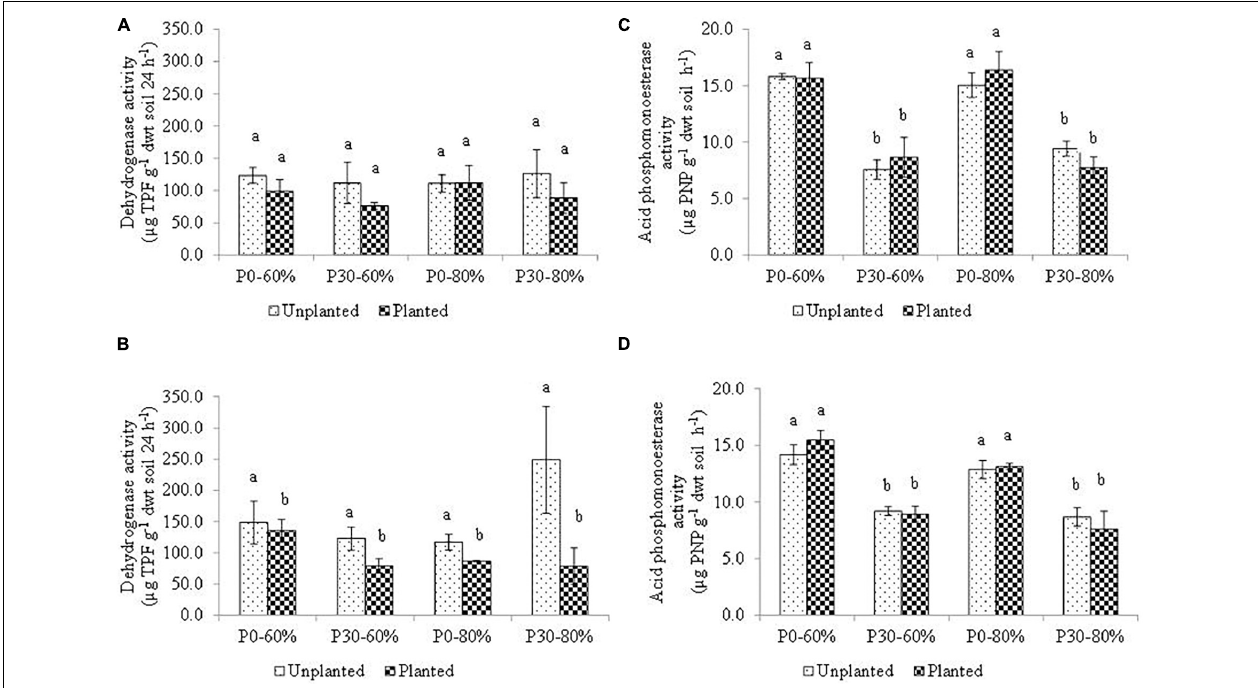
FIGURE 4 | Mean dehydrogenase activity measured in bulk soil within the (A) D1 and (B) D5 and mean acid phosphomonoesterase measured in bulk soil within the (C) D1 and (D) D5 sub-sections of sampled mesocosm. Activity was measured after four months incubation in a growth chamber. Soil used in the experiment originated from an established inorganic phosphorus (P) fertilization field trial (44 years) which had either remained unfertilized (P0) or had received 30 kg ha − 1 y − 1 (P30) of inorganic P. Soil water holding capacity was altered to 60% and 80% and was maintained within a growth chamber for four months. Error bars represent standard error of the mean ( n = 3). Significant differences are indicated by letters ( p <